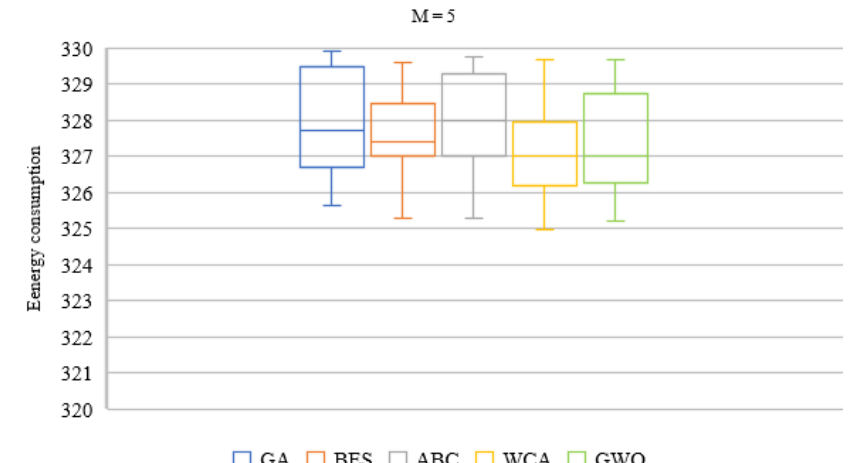
Figure 10. Box plot of objective function values.